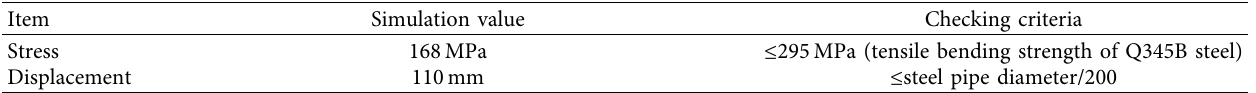
Figure 19: Results of steel cylinder displacement test: (a) displacement distribution; (b) horizontal displacement distribution; (c) vertical displacement distribution. Table 7: Numerical simulation results.